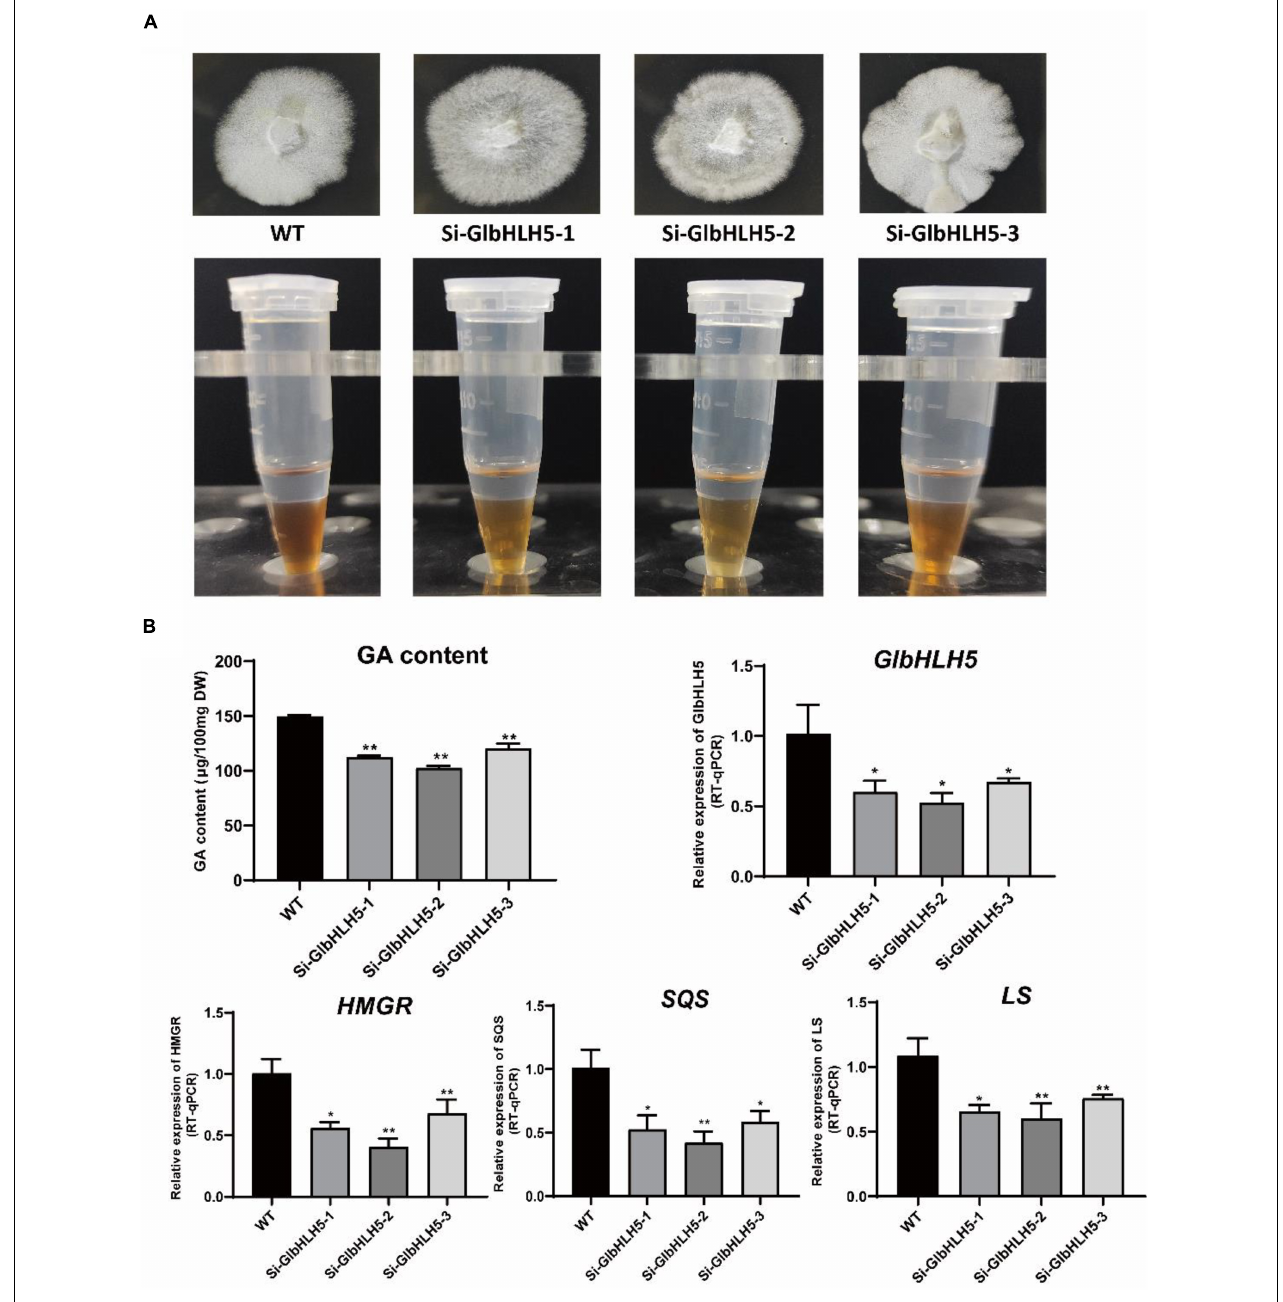
FIGURE 7 | Phenotypic and gene expressions analysis of the GlbHLH5 silencing strains. (A) The phenotypes of the three GlbHLH5 silencing and the control lines of Ganoderma lucidum and the coloration differences between extracts of different lines. (B) The quantitative analysis of triterpenoids and the key genes transcriptions of the biosynthetic pathway in the GlbHLH5 silencing and the control lines. “*” means the difference is significant ( P < 0.05) and “**” means the difference is extremely significant ( P <